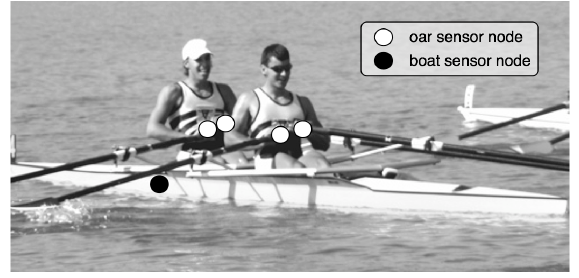
Figure 1. Position of the sensor nodes on the